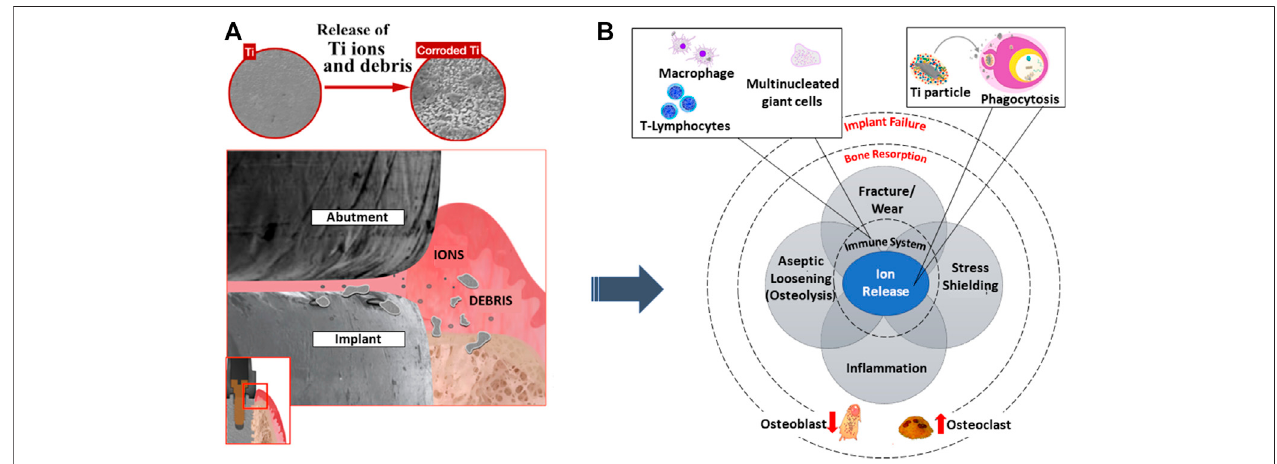
FIGURE 3 | (A) The start of foreign ions leaching, adversely affecting (B) immune response activities leading to bone resorption and implant failure. Image remodeled from Souza et al. (2020).